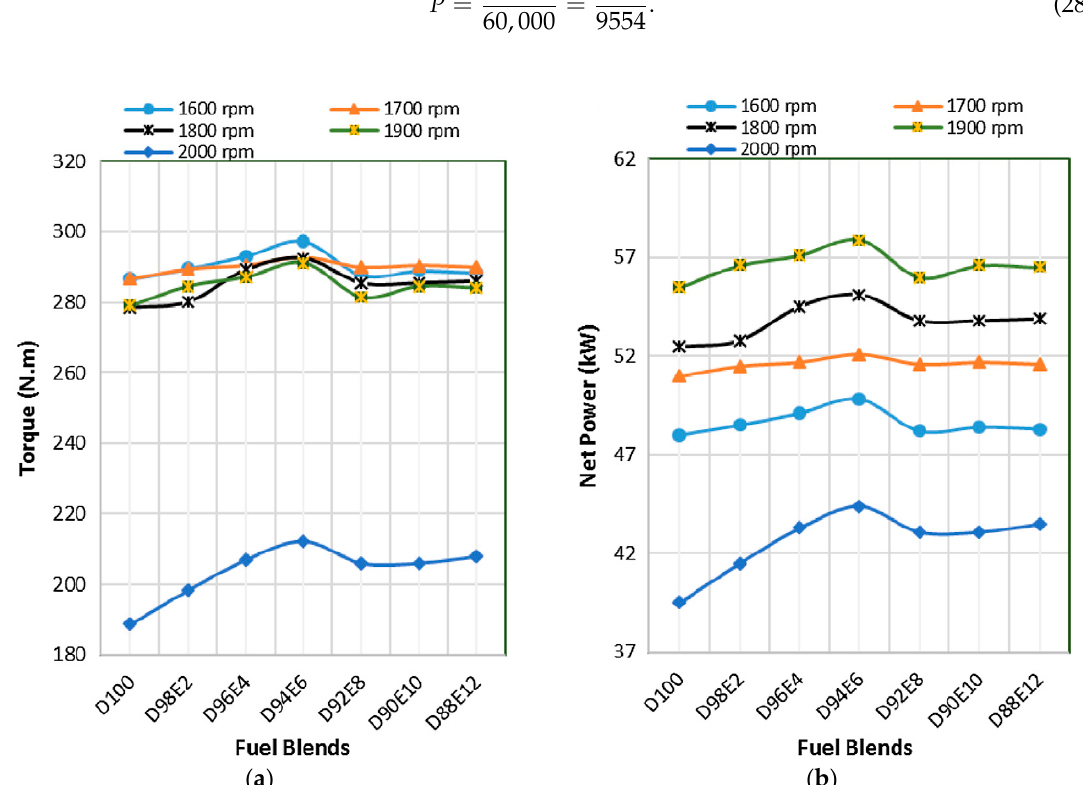
Figure 22. The generated ( a ) torque and ( b ) power of the ethanol/diesel fuel blends, at the speeds of 1600 − 2000 rpm. [85]. Figures are reprinted with permission from publisher.